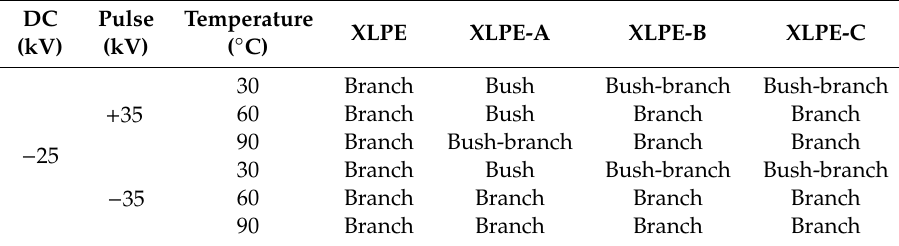
Table 1. Tree structure distribution at 1